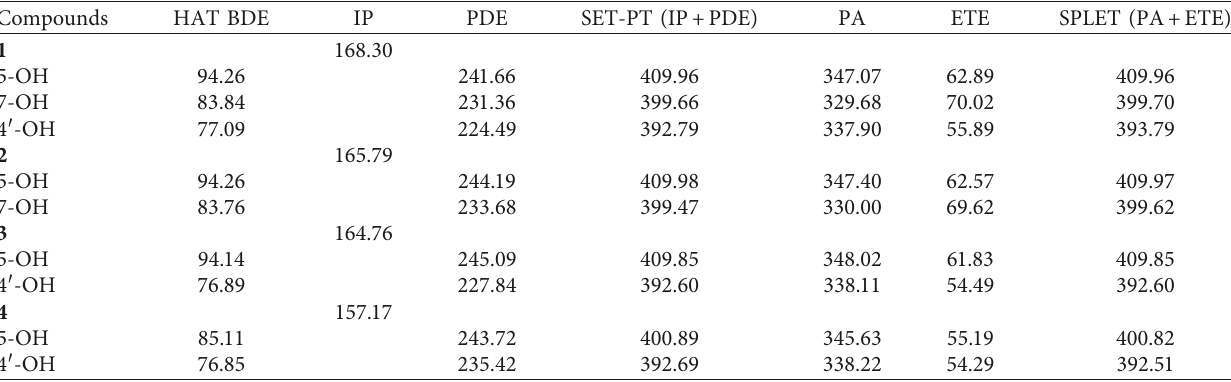
Table 3: Gas phase reaction enthalpies at 298 K for radicals of the studied compounds at B3LYP/6-311G(d) level of theory (in kcal/mol). Compounds HAT BDE